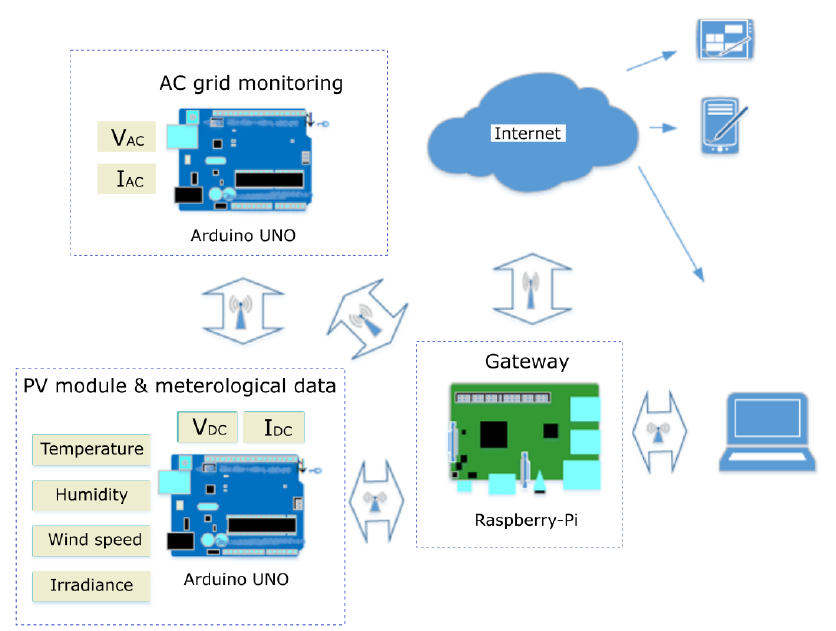
Figure 1. Proposed wireless